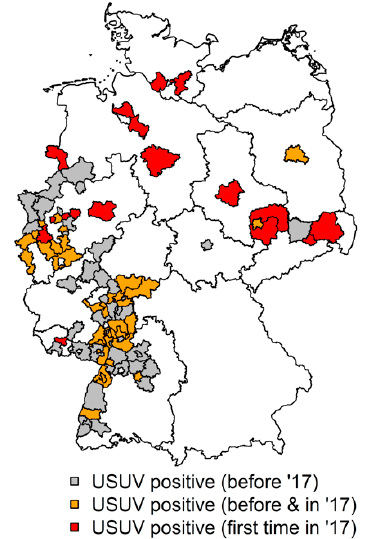
Figure 4. USUV detection in dead birds (second sample panel) in 2017 (red areas = USUV-positive birds detected for the first time in 2017, yellow areas = USUV-positive birds detected before and in 2017, grey areas = distribution of USUV-positive birds in the previous years, but no cases in 2017).